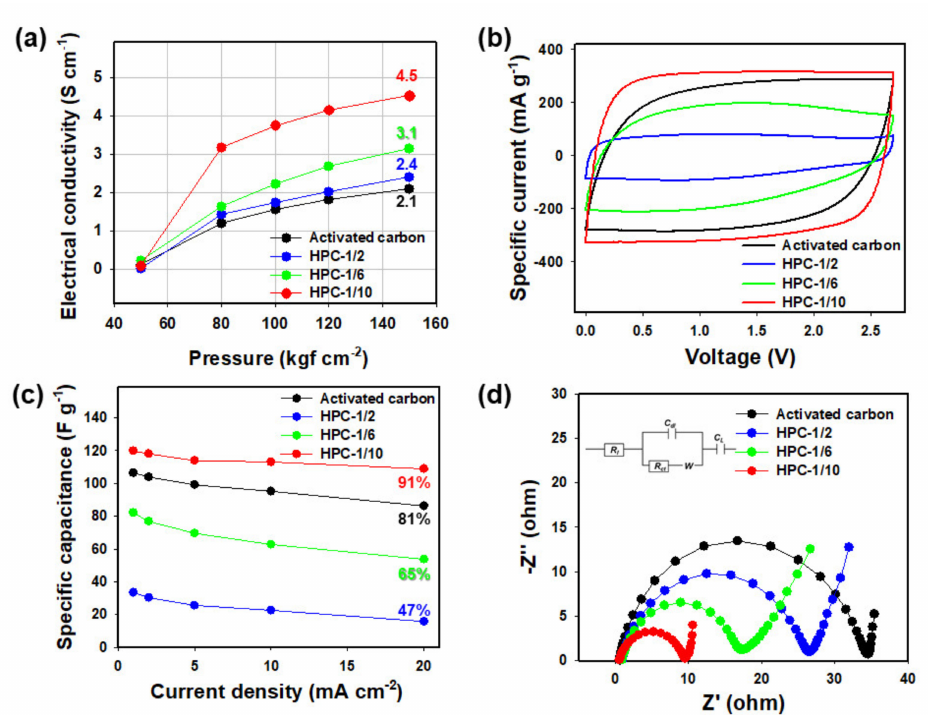
Figure 4. ( a ) Cyclic voltammograms at 5 mV s − 1 and ( b ) electrical conductivity of activated carbon and HPC samples under various compressive pressure values. ( c ) Rate capabilities at various current densities. ( d ) Nyquist plots recorded at frequencies between 200 kHz and 100